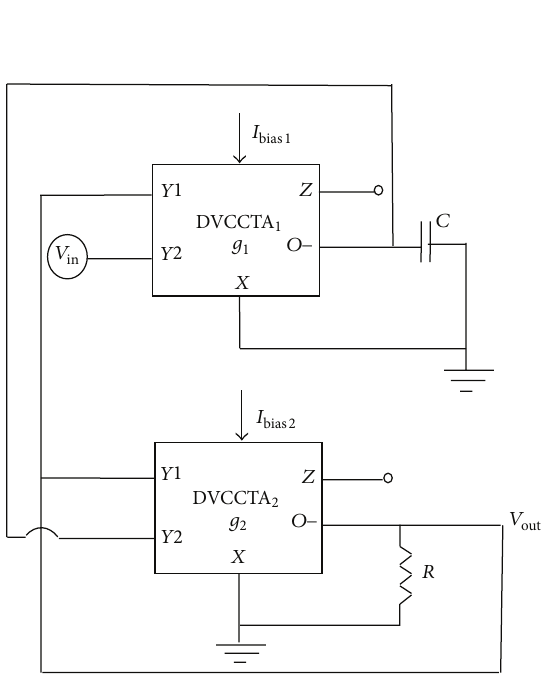
Figure 9: Sigma delta modulator scheme.